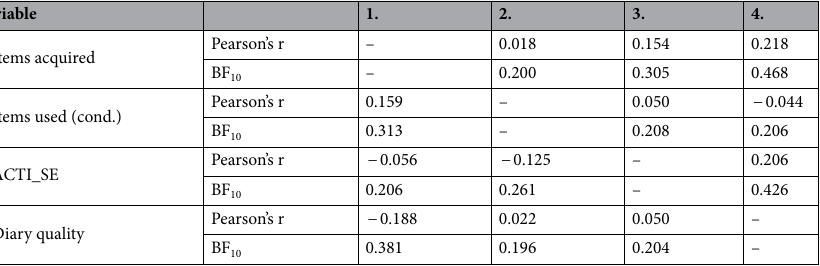
Table 2. Pearson and Bayesian correlations between sleep quality and episodic foresight variables separated by age group. Results below the diagonal are for older adults. Results above the diagonal are for younger adults. BF 10 Bayes Factor indicative of evidence for the alternate hypothesis, ACTI-SE actigraphy assessed sleep efficiency. Items acquired = percentage of correct items acquired. Items used (cond.) = the proportion of items used to items acquired. No correlations were significant.